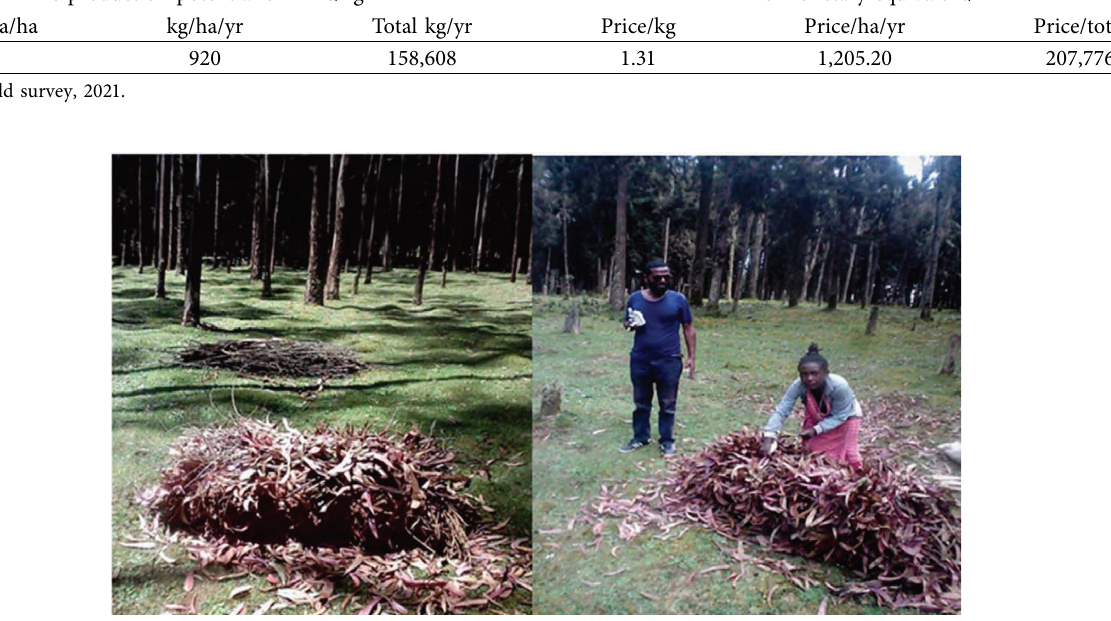
Figure 7: Raking of litter/BLTs from the Surra government plantation (source: feld survey,